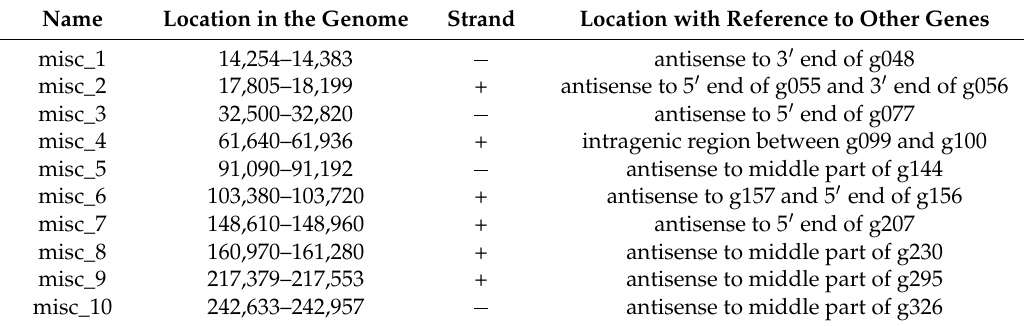
Table 1. Identified novel non-coding RNA